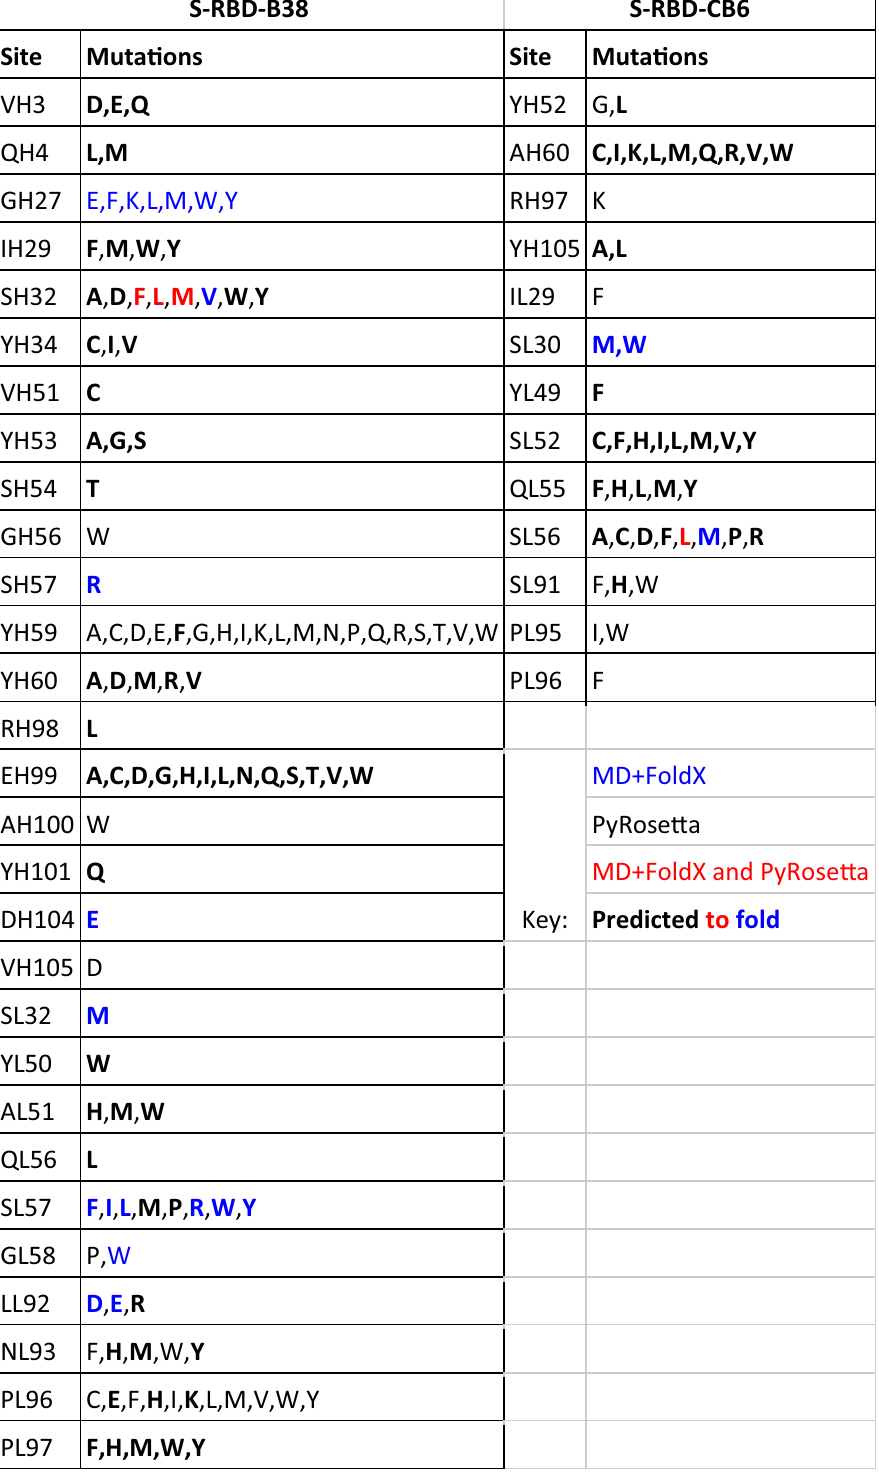
Table 3. Union of the individual datasets for predicting antibody strengthening mutations from MD + FoldX and PyRosetta. The left table contains those predicted for B38, and right is for CB6. The left column in each subtable is the site and the right column shows the list of mutations predicted to strengthen the binding interaction between the S-RBD and the antibody. Predicted strengthening mutations are colored based on whether both methods predict strengthening (red), only MD + FoldX predicts strengthening (blue), or only PyRosetta predicts strengthening (black). Bold font denotes mutations that are predicted to allow